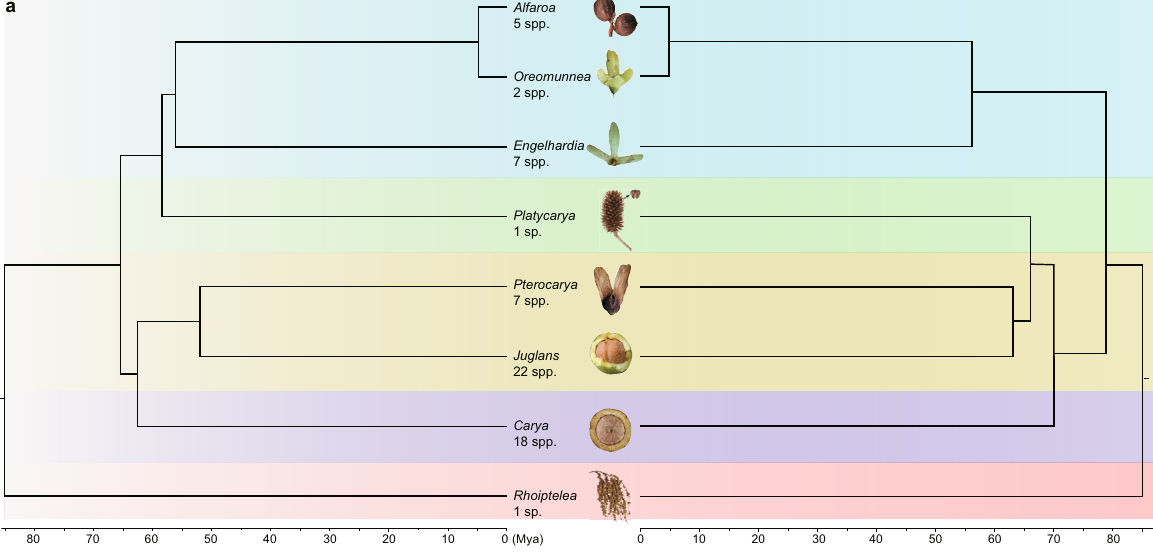
Pterocarya paliurus following 22,98 , and Alfaropsis roxburghiana (Wall.) Iljinsk. is treated as Engelhardia roxburghiana (compare Supplementary Fig. 16). The fruit photos arenotto scale,and theMyascaleisbased ontheoldestfossiloccurrences of the respectivegenera, but without a formalanalysis. b The phylogenetictree on the right is adapted from Mu et al . 15 who used nuclear RAD-Seq and whole- chloroplast alignment